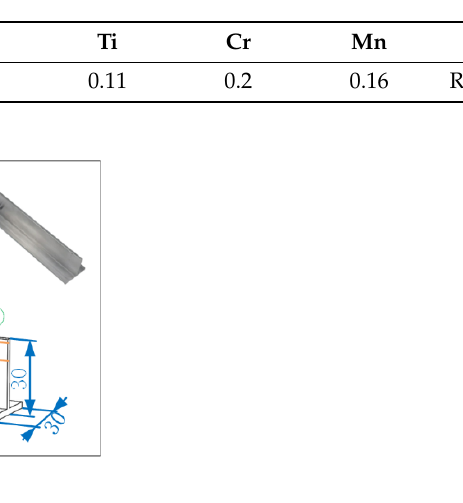
Figure 2. Rolling correction processing of structural parts.